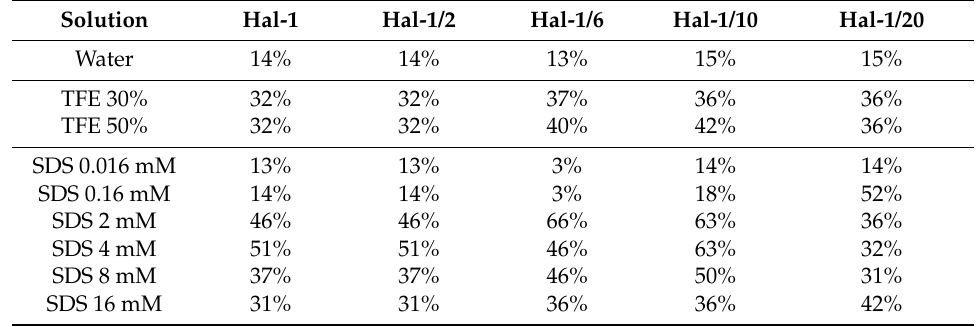
Table A2. Estimation of the secondary structure content calculated from ECD spectra using the CDPro package [62,73] for HAL-1 and its analogs in aqueous solution, and in the presence of SDS.